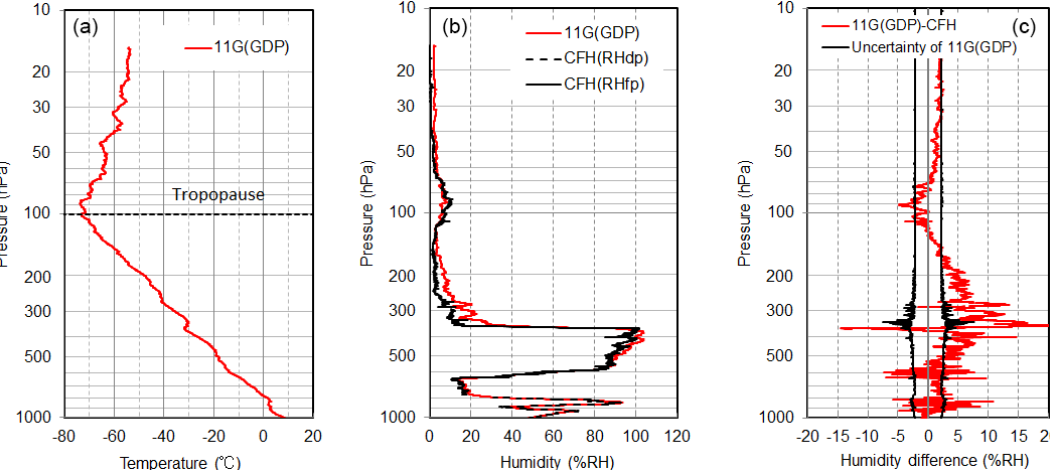
Figure 28. Profiles of temperature and RH / RH difference from an RS-11G and CFH comparison flight launched at 14:50 (LST) on 10 November 2016. Panel (a) shows temperature data from RS-11G GDP. Panel (b) shows the RH of RS-11G GDP (red), converted RH from CFH dew point temperature (black dashed line) below the height of the forced freezing point (Vömel et al., 2007), and converted RH from CFH frost point temperature (black thick line) above the height of the forced freezing point. Panel (c) shows RS-11G GDP minus CFH humidity difference (red) and the overall uncertainty of RS-11G GDP (black).